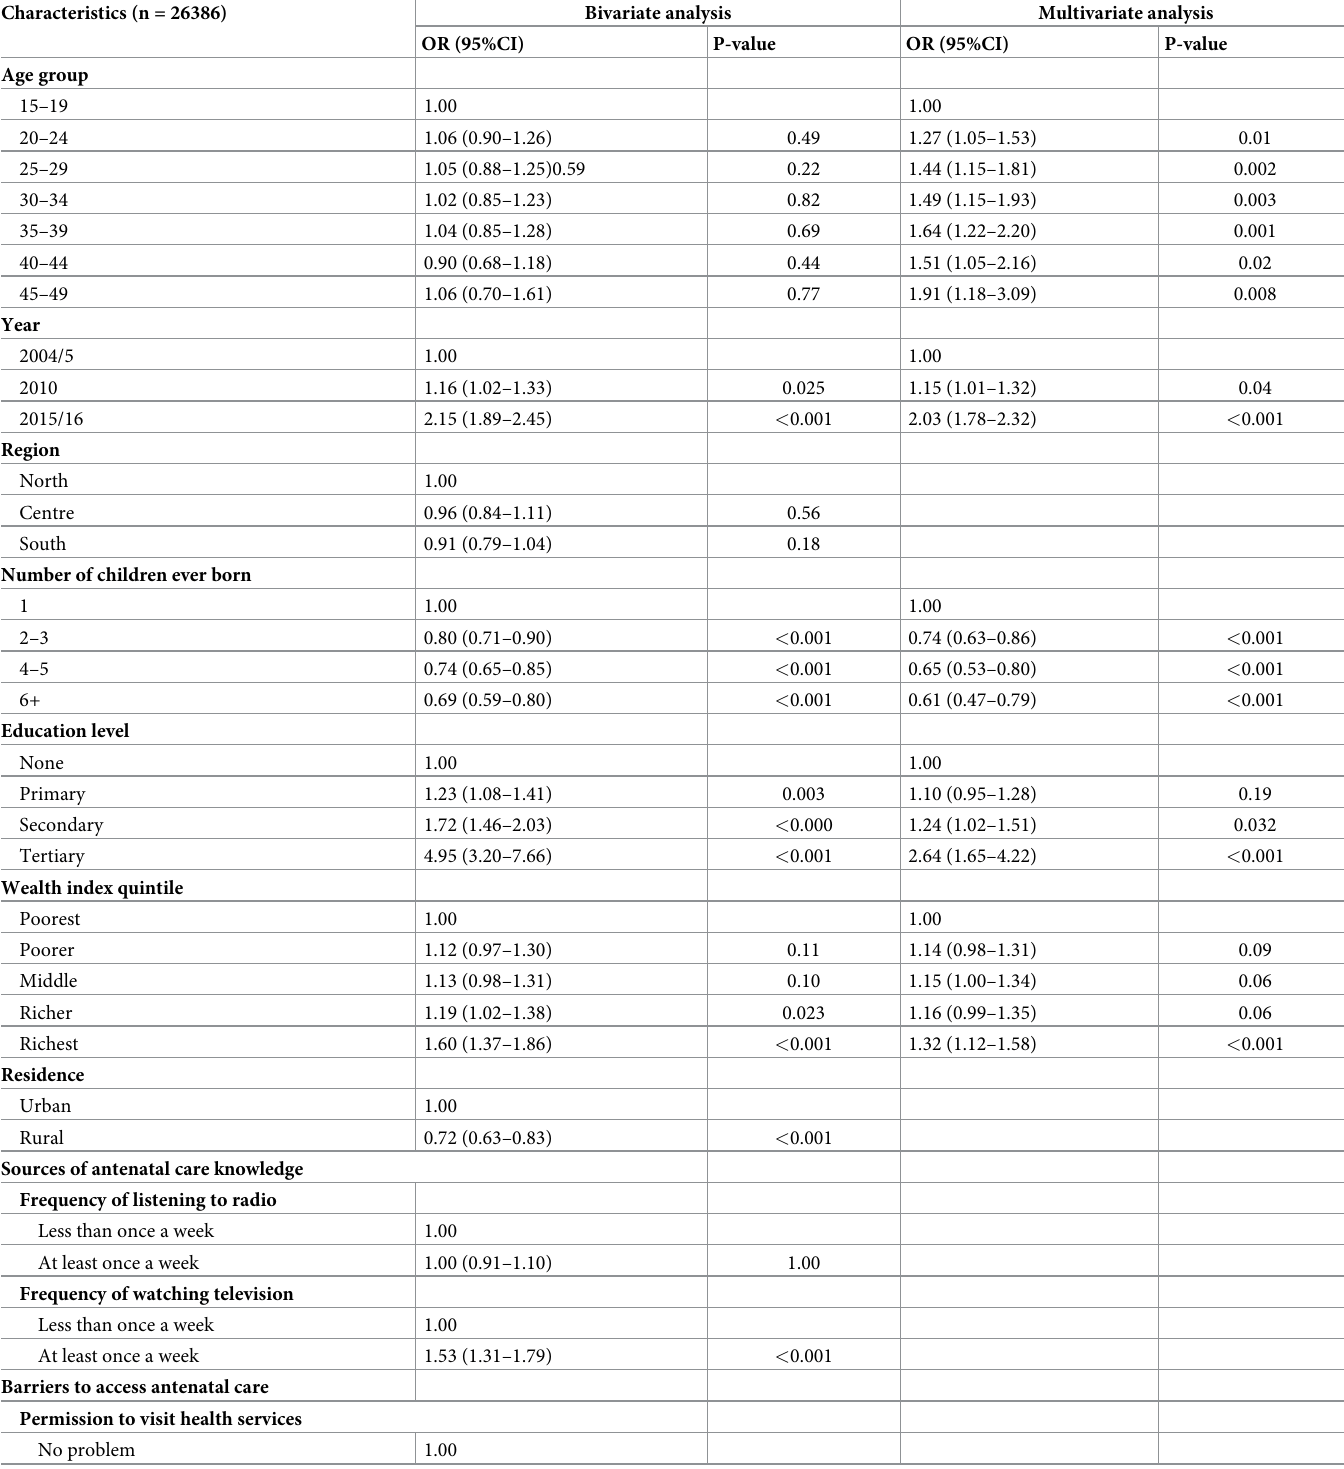
Table 3. Bivariate and multivariate odds ratios for factors associated with attending at least four or more antenatal care visits prior to prior to six months of first antenatal care visit in Malawi,